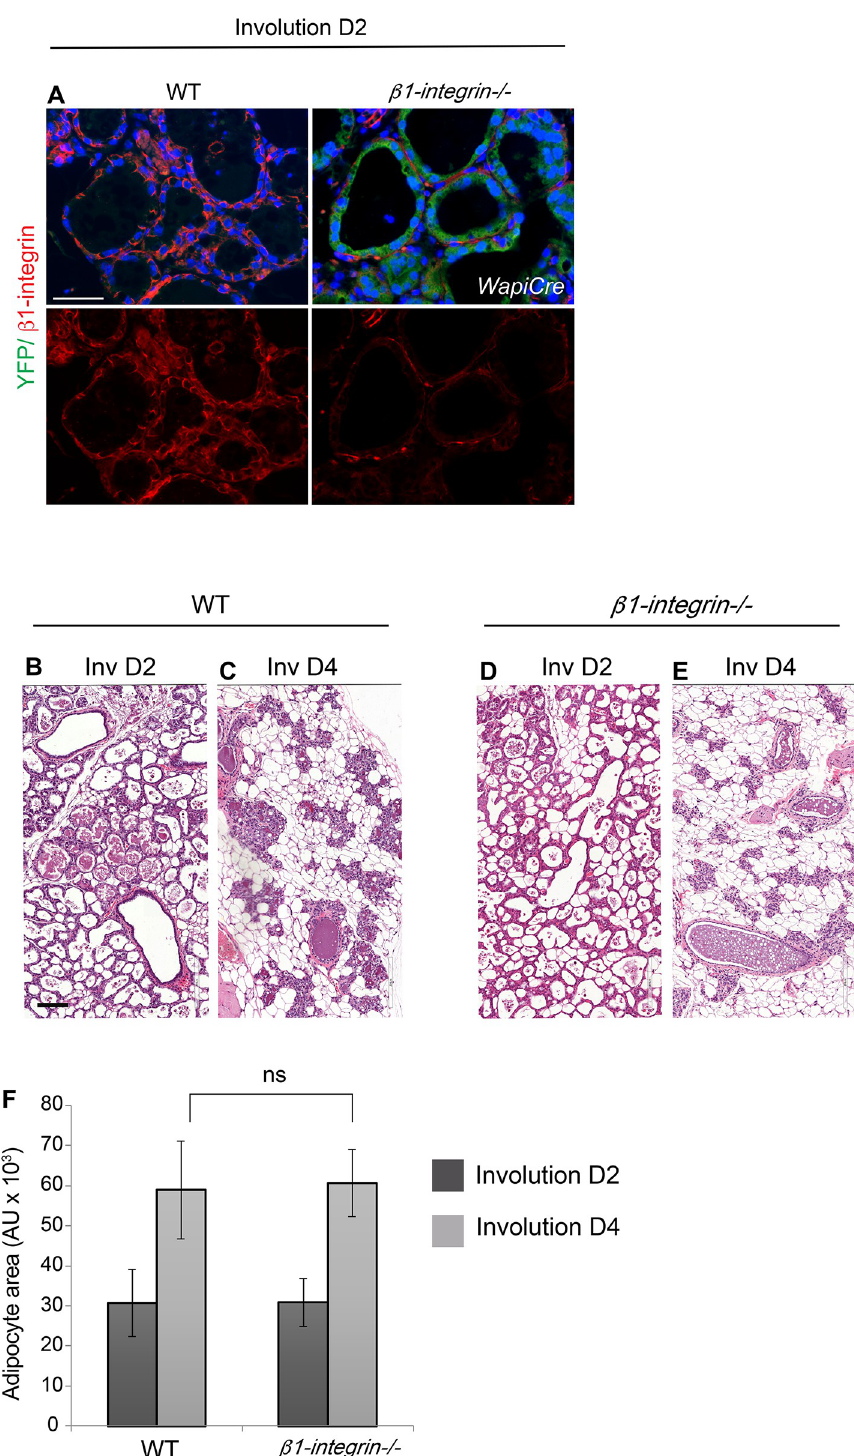
Fig 2. Ablation of β 1-integrin does not phenocopy the Rac1−/− involution phenotype. ( A ) Ablation of β 1-integrin in luminal cells at involution day 2 was detected by immunofluorescence staining with a β 1-integrin antibody (red). YFP reporter gene expression (green) confirmed Cre-mediated recombination in transgenics. Bar: 50 μ m. ( B - E )HE stains at involution days 2 and 4 show no delay in alveolar regression in β 1-integrin−/− mice. Both WT glands ( A , B ) and β 1-integrin−/− ( C , D ) glands equally regressed. Bar: 100 μ m. ( E ) Quantification of adipocyte repopulation. Error